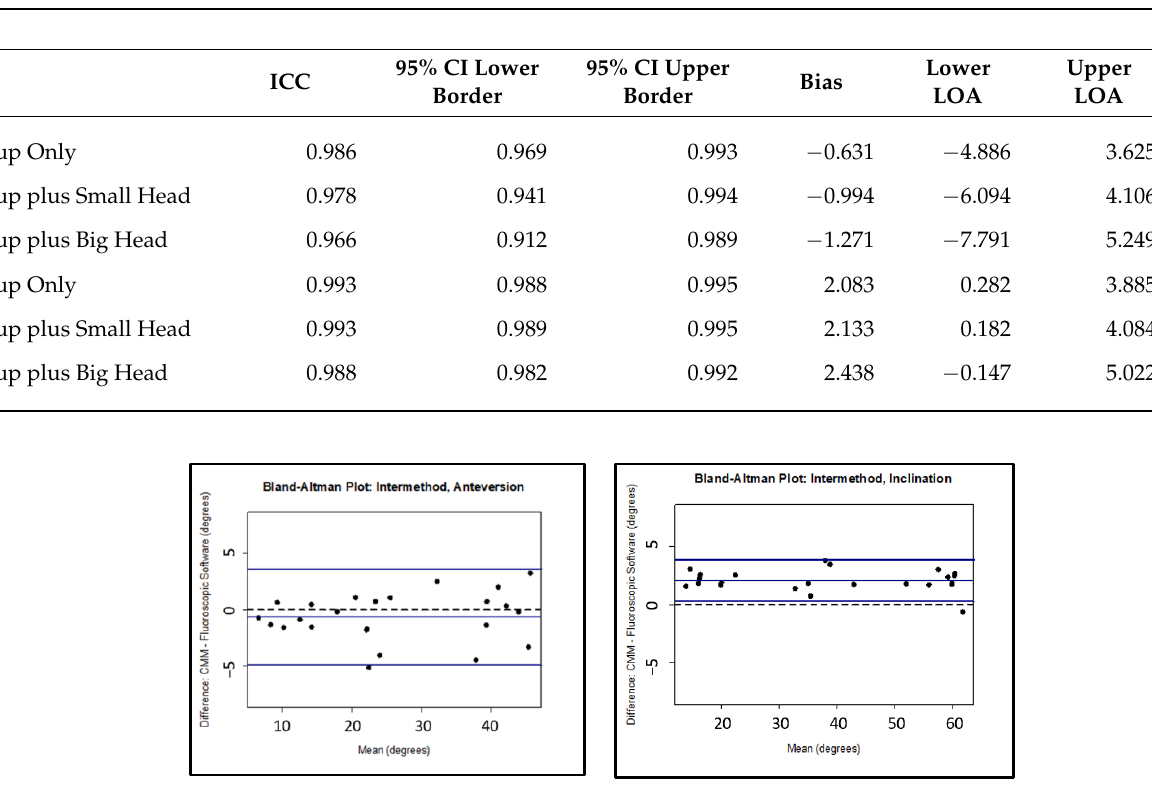
Table 3. Complete intermethod analysis comparing the software analysis to the CMM analysis includ-